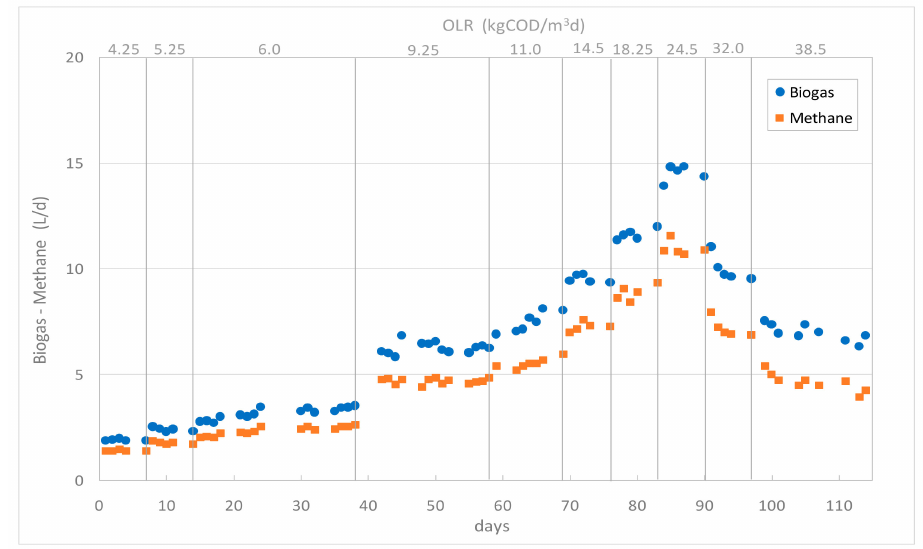
Figure 3. Biogas and methane productions over the pilot plant operational